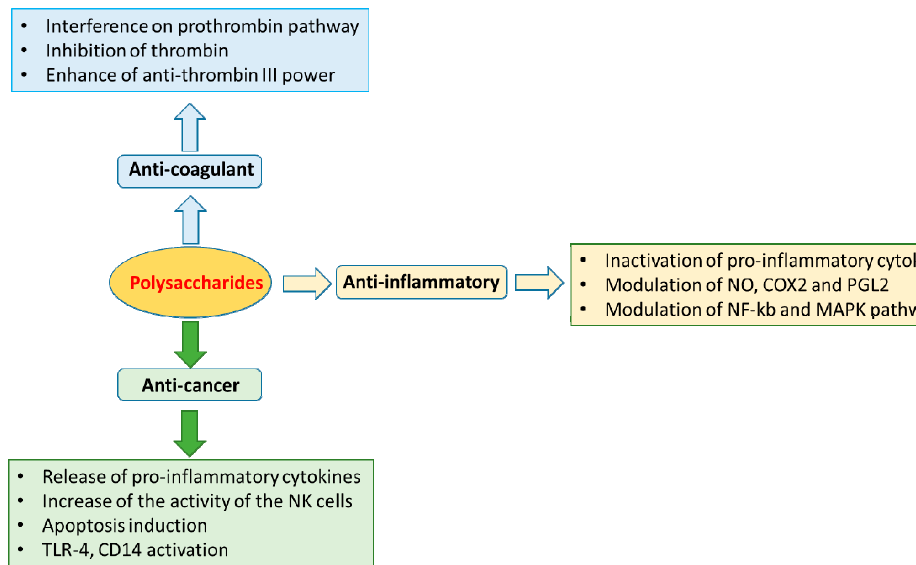
Figure 3. Properties of marine polysaccharides and their applications in pharmacology.